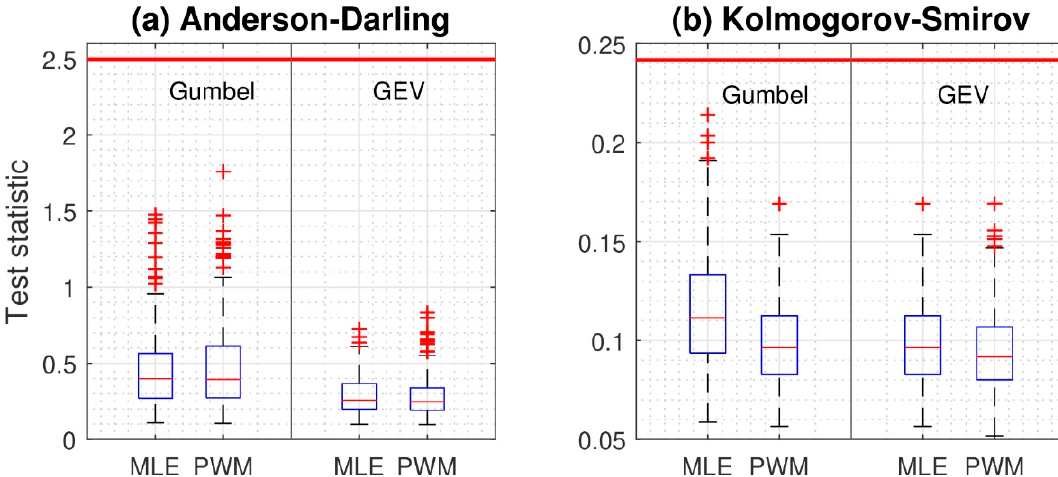
Figure 1. Goodness of fit tests, ( a ) Anderson-Darling test and ( b ) Kolmogorov-Smirnov test for Gumbel and Generalized Extreme Value (GEV) distributions with parameter estimations by the Maximum Likelihood Estimation (MLE) and Probability Weighted Moment (PWM) methods. The number of the boxplot samples for each test is 320 (40 locations × 8 durations). The red line represents the critical value of Anderson-Darling and Anderson-Darling tests (2.49 and 0.24, respectively). On each boxplot, the central mark indicates the median, and the bottom and the top edges of the box indicate the 25th and 75th percentiles, respectively. The ‘+’ symbol represents the outliers, and the whiskers extend to the most extreme data points, not considers outliers.